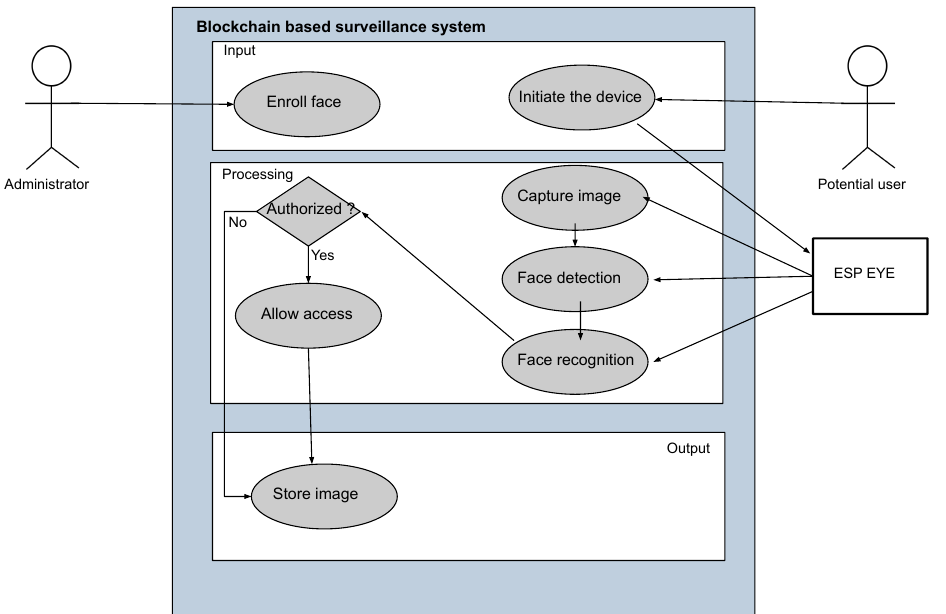
Figure 2. High-Level Use Case